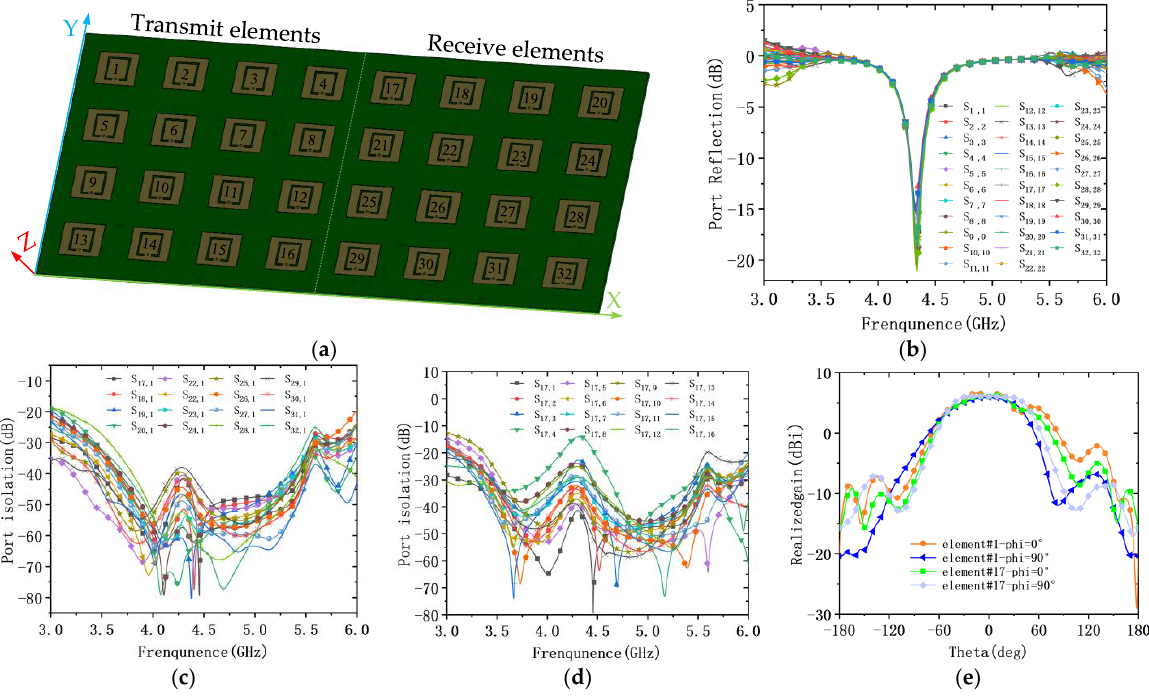
Figure 3. Array configuration and its performance: ( a ) Array configuration; ( b ) Port reflection coefficient; ( c ) The coupling of the array element #1 to each receive array element; ( d ) The coupling of each transmit element to the array element #17; ( e ) The pattern of the array element #1 and the array element #17.